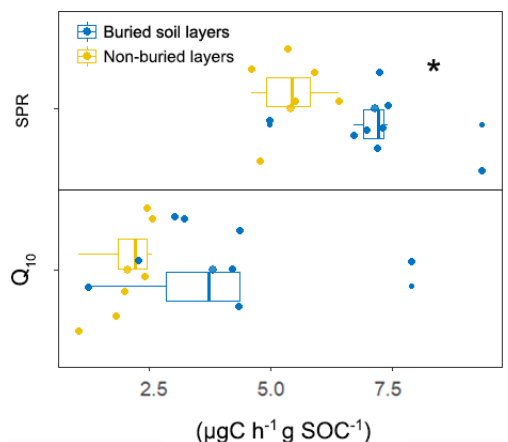
Figure 4. Boxplot of soil potential respiration (SPR) rates and SOC temperature sensitivity ( Q 10 ). The ∗ signifies differences in SPR or Q 10 between buried and non-buried soil layers ( P < 0.05). Identifi- cation of buried soil layers is based on the depth profile of SOC con- centration and soil chemical weathering degree with support from the stretch map in Fig. 1 (see details in S1 in the Supplement).